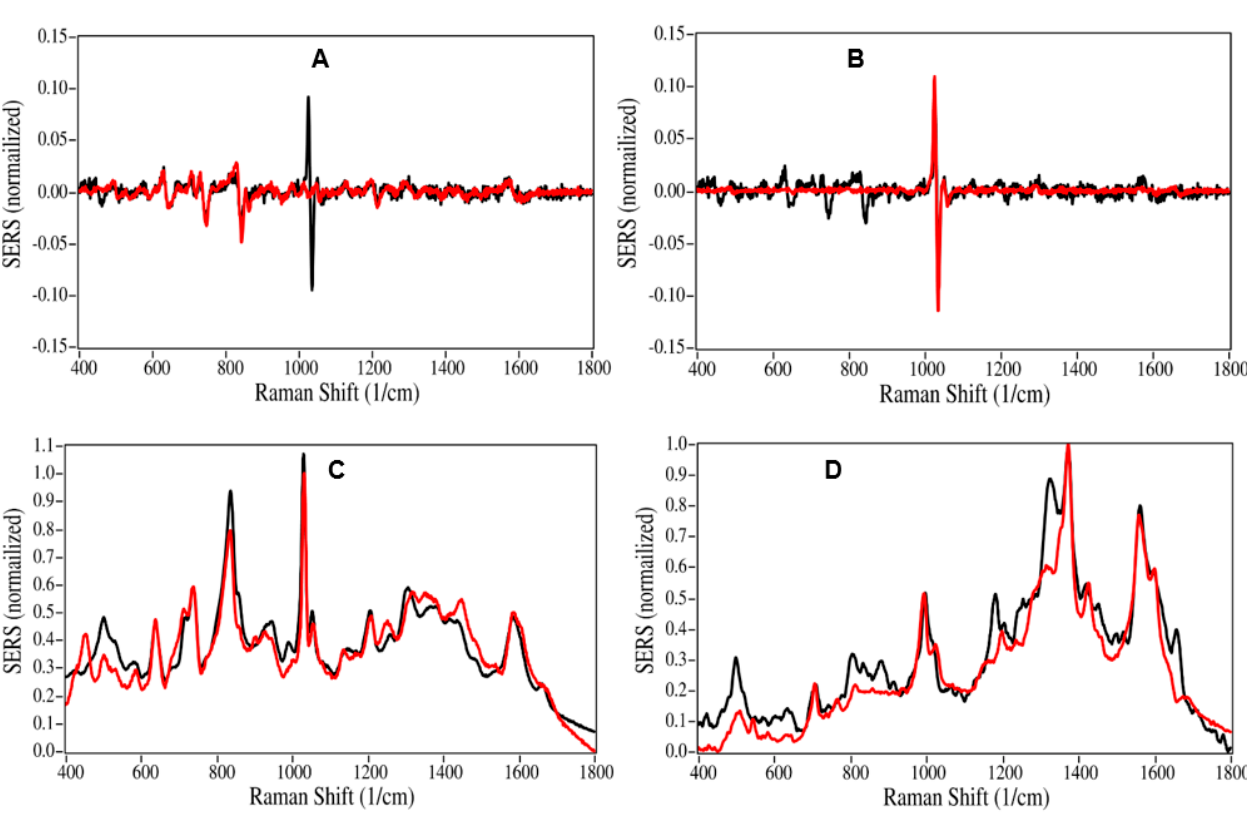
Figure 1. SERS of Sample 1 first derivative (black) overlaid with ( A ) first derivative of buprenorphine (red), ( B ) overlaid with first derivative of nicotine (red). ( C ) Overlay of Sample 1 spectrum (red) on the predicted spectrum composed of 54% buprenorphine and 46% nicotine (black). ( D ) Overlay of Sample 13 spectrum (red) on predicted spectrum composed of 95% ibuprofen and 5% norbuprenorphine (black). Conditions: 100 mg/L sample in water, 40 mW at 785 nm, 1 sec acquisi- tion.